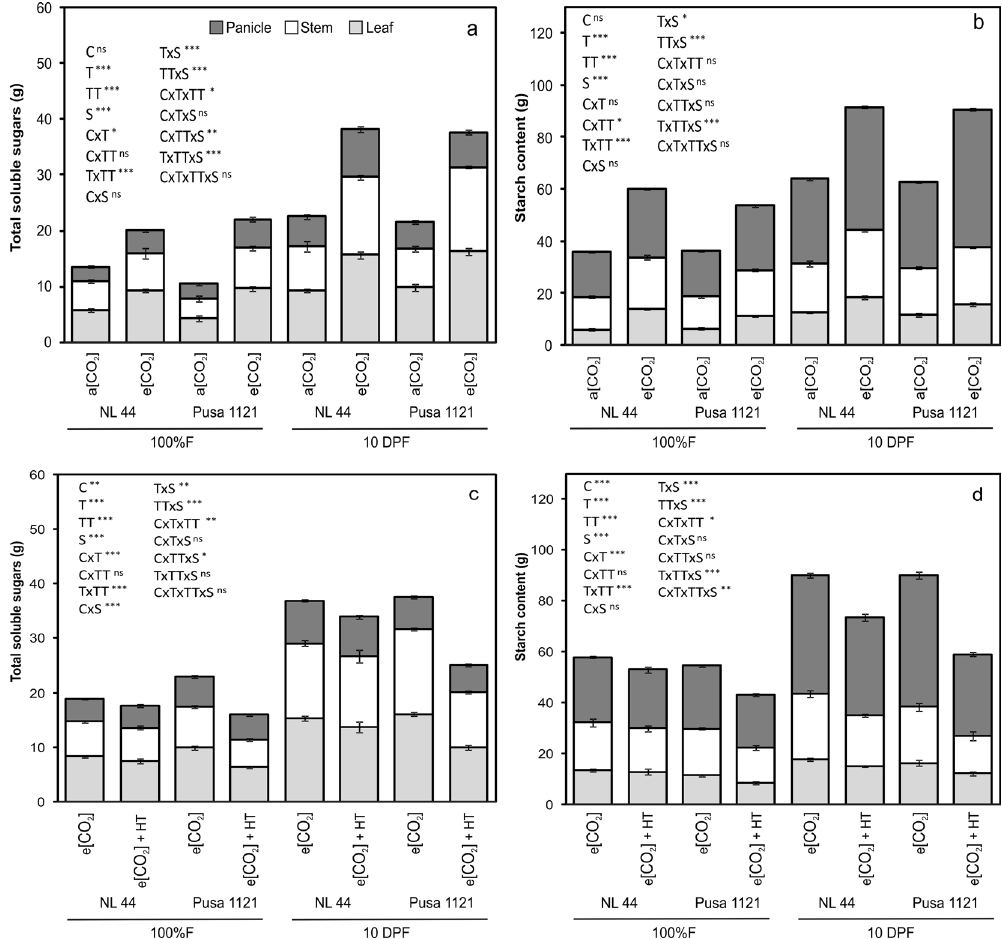
Figure 2. Changes in total soluble sugars and starch content in different plant parts (leaf, stem and panicle) of rice cultivars NL-44 and Pusa 1121 at 100% flowering (100% F) and at 10 days post 100% flowering (10 DPF) under ambient and elevated [CO 2 ] during 2013 ( a , b ) and elevated [CO 2 ] and elevated [CO 2 ] + HT environment during 2014 ( c , d ). Each box in vertical stacked column represents mean of three replicates. Bars indicate ± SE. Asterisks indicates level of significance * P < 0.05 , ** P < 0.01 , *** P < 0.001 , ns = non significant. [C = cultivar; T = treatment; TT = tissue type; S = growth